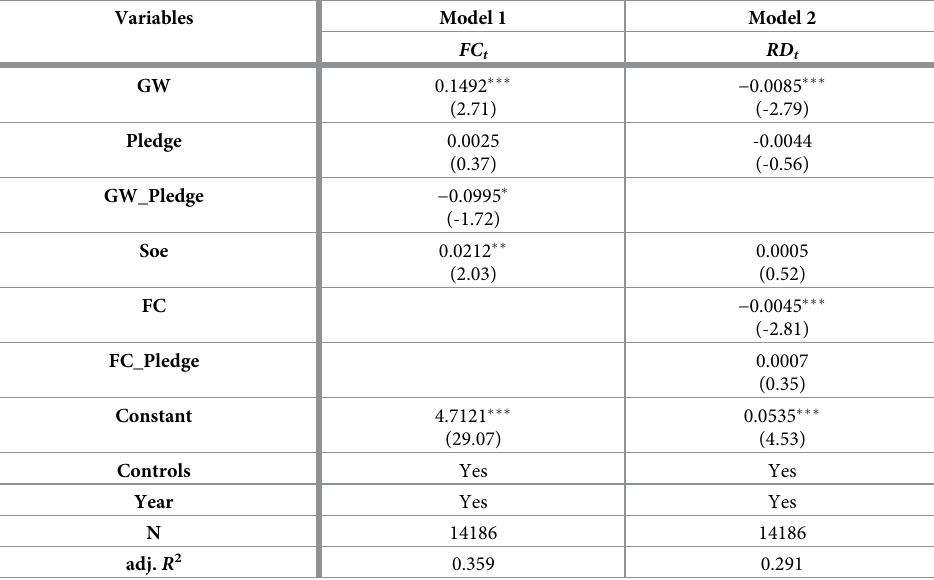
Table 6. Moderated mediation test for stock pledges by controlling